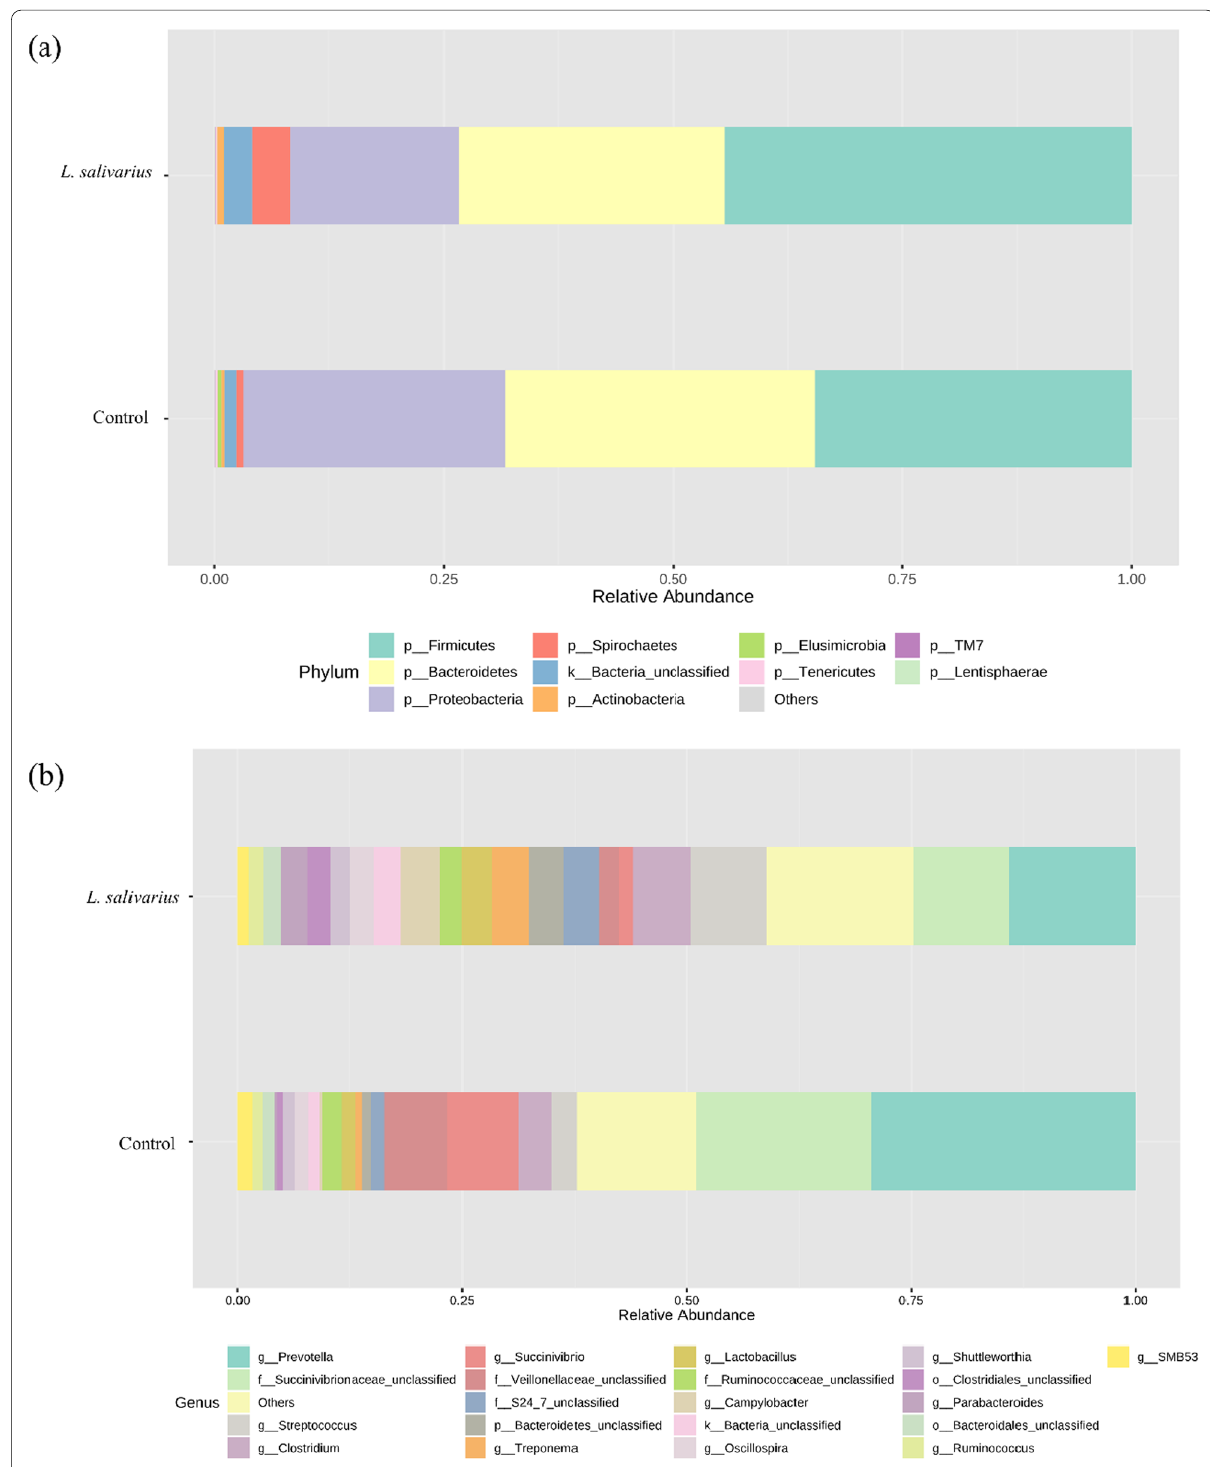
Fig. 2 The effect of heat-killed L. salivarius supplementation on the fecal microbiota composition at the phylum and genus levels. a The color corresponds to phylum, and b the color corresponds to